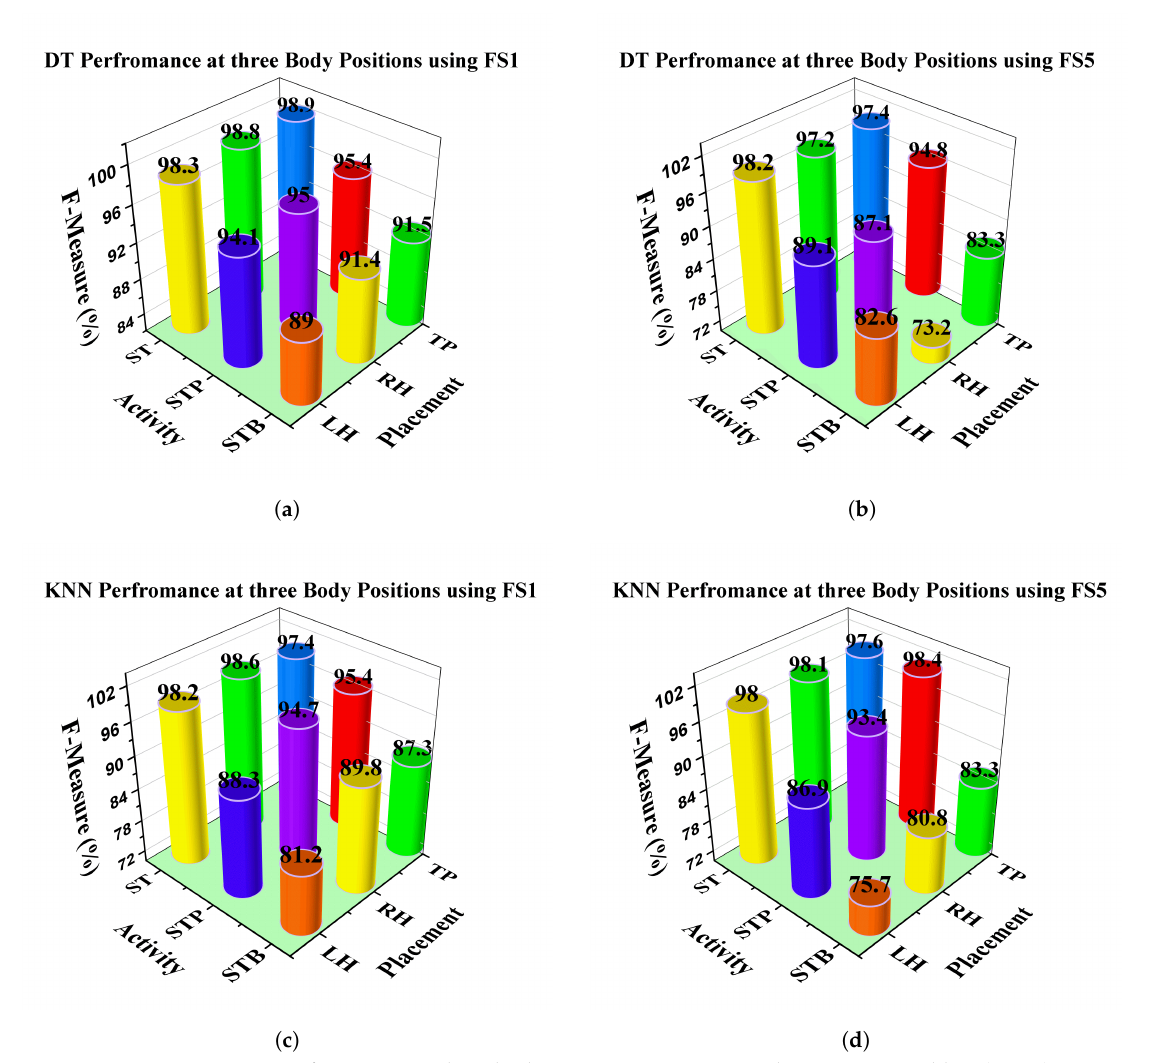
Figure 7. Recognition of activities at three body positions using DT and K-nearest neighbor (KNN) at the 12 s window . Table 9. Confusion metrics for fs1 and fs5 at the LH position achieved through